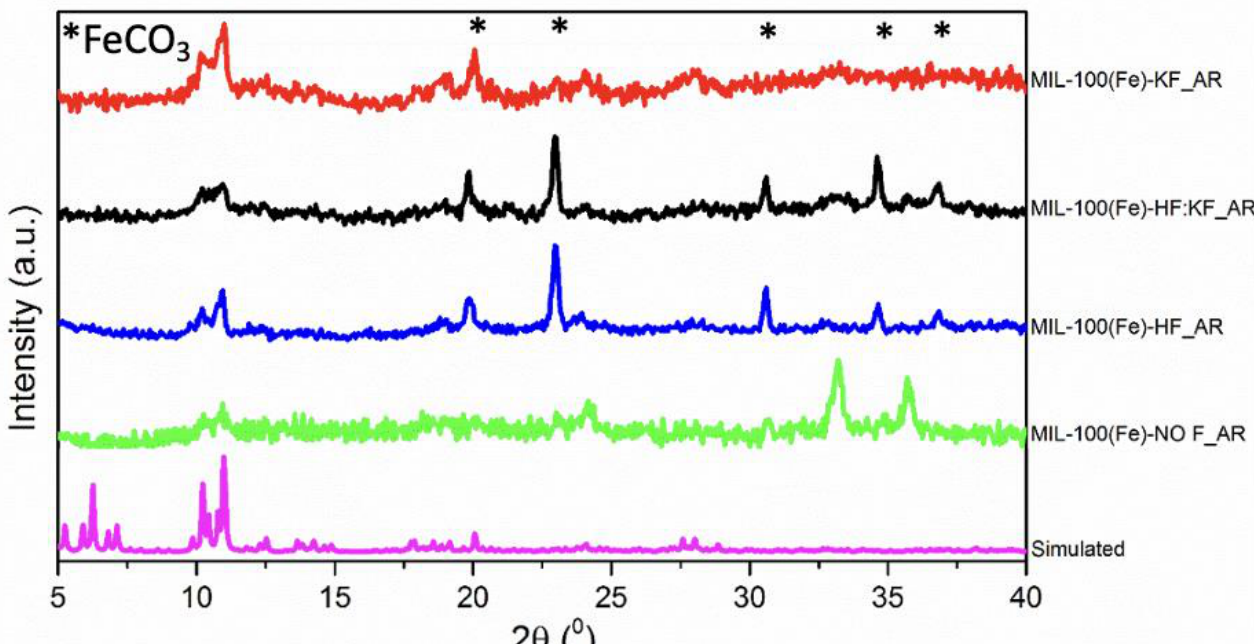
Figure 9. XRD pattern of the MIL-100(Fe) samples after the reaction (AR), compared to the simulated MIL-100(Fe). * Show the FeCO 3 phase.